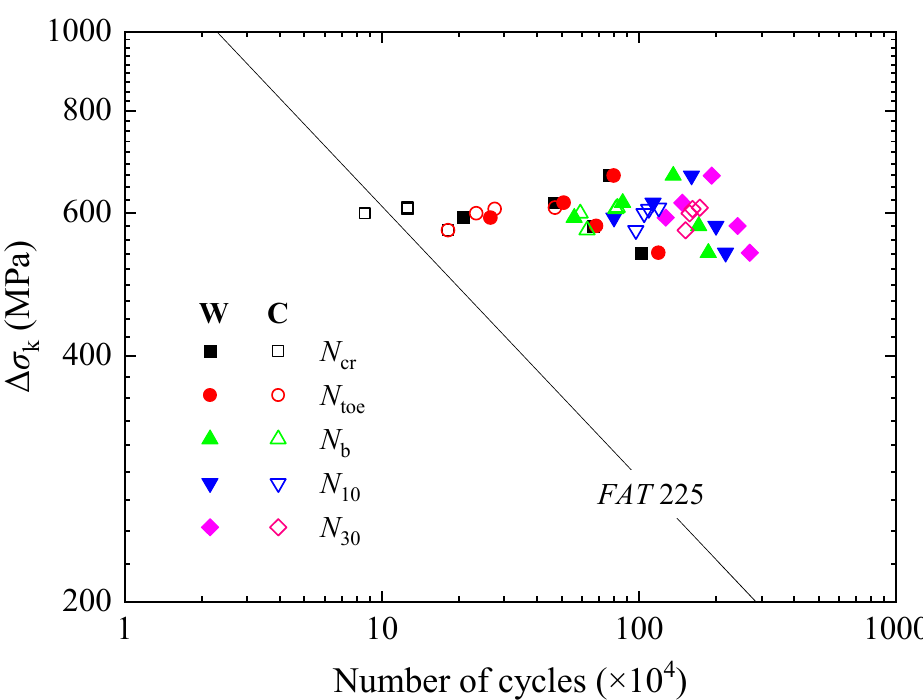
Figure 15. Comparison of fatigue data with S - N curve for effective notch stress range. Table 7. Statistical estimation of fatigue strength. Group